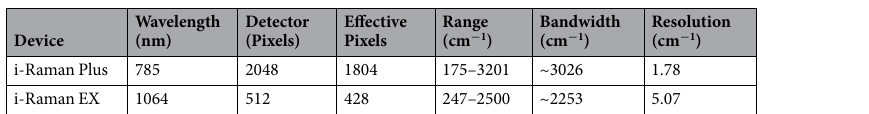
Table 4. Operating characteristics for the i-Raman Plus and i-Raman EX